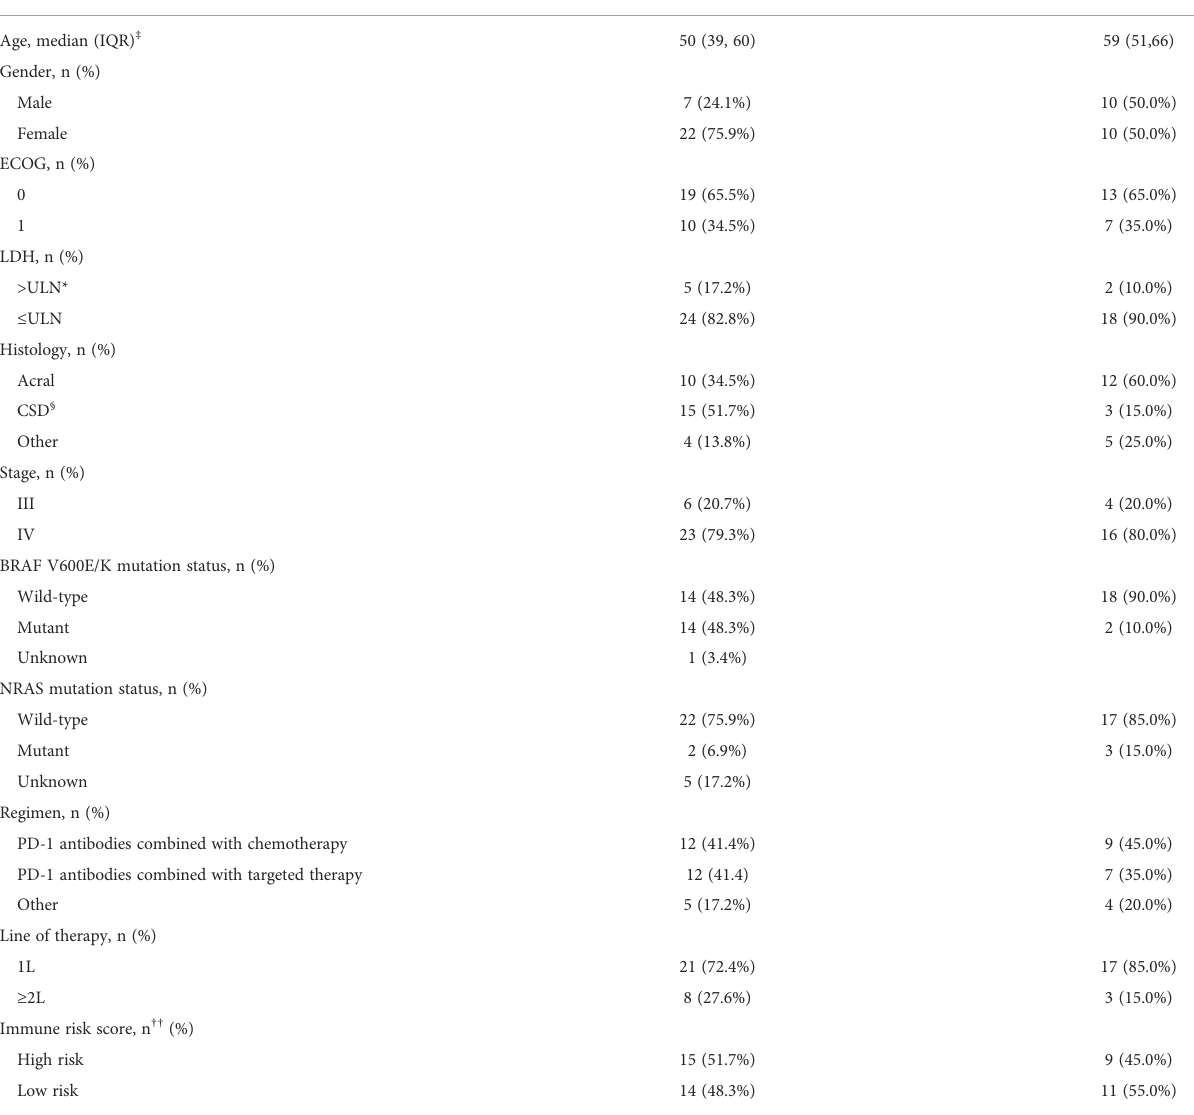
TABLE 1 Baseline characteristics of the training set and validation